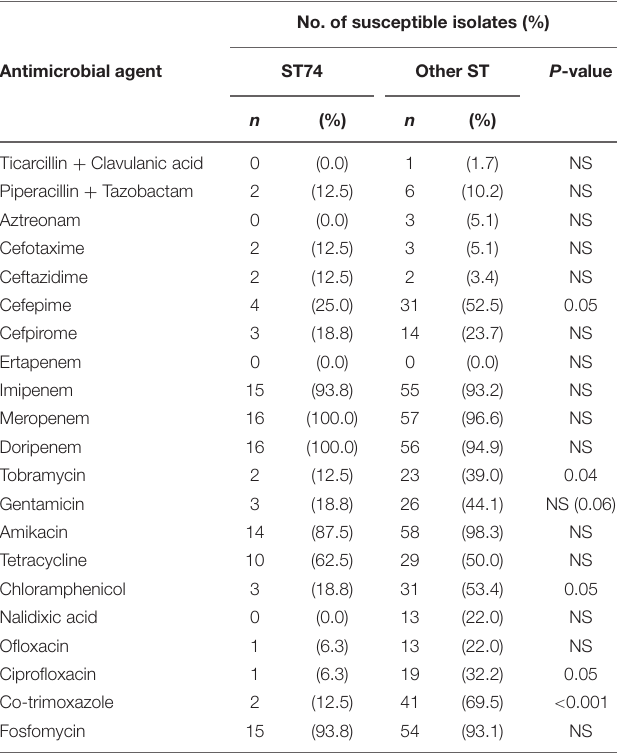
TABLE 6 | Susceptibility rates of E. cloacae isolates to various antimicrobials according to the ST type. No. of susceptible isolates